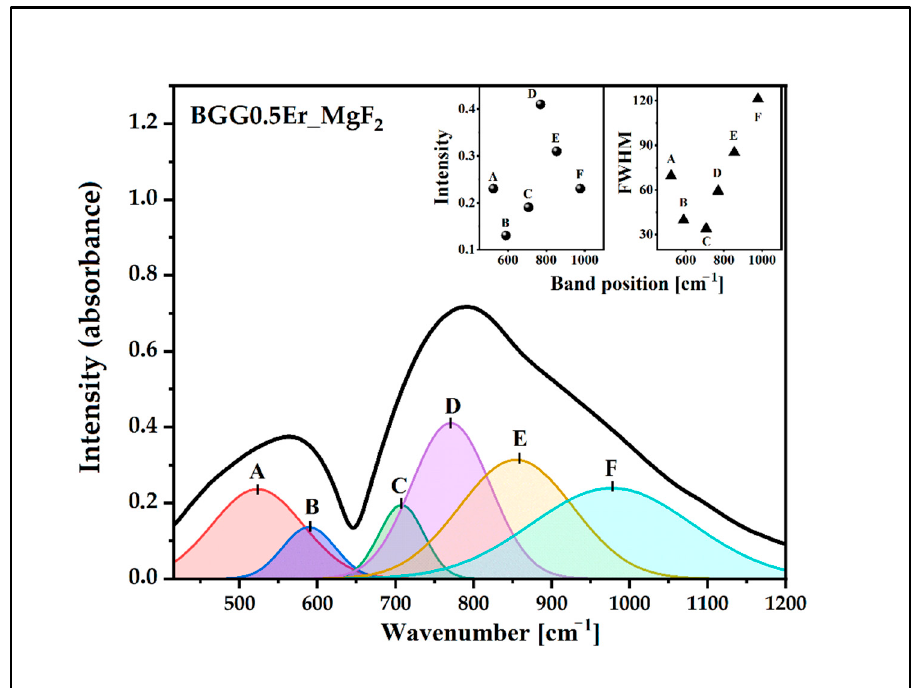
Figure 7. Deconvoluted IR spectrum of BGG0.5Er_MgF 2 glass.